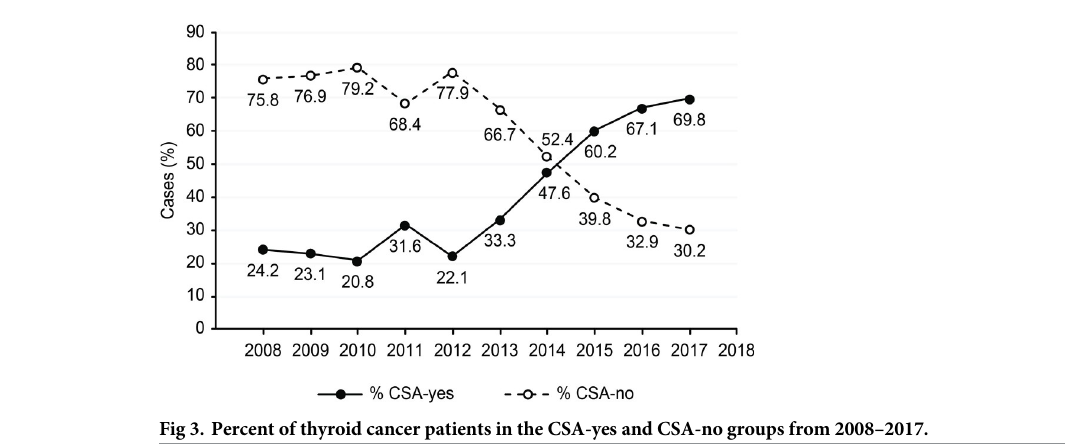
characteristic of potentially aggressive TC behavior were not observed in patients in the CSA- yes group but were predominant in patients in the CSA-no group (p < 0.0001 for all variables) (Table 3). In the CSA-yes group, we observed small, low-risk tumors (Table 3). Finally, we per- formed an analysis of TC presurgical diagnosis in the CSA-yes and CSA-no groups (CSA-yes vs. CSA-no) (Table 4) and estimated that the number of patients with TC diagnosed before